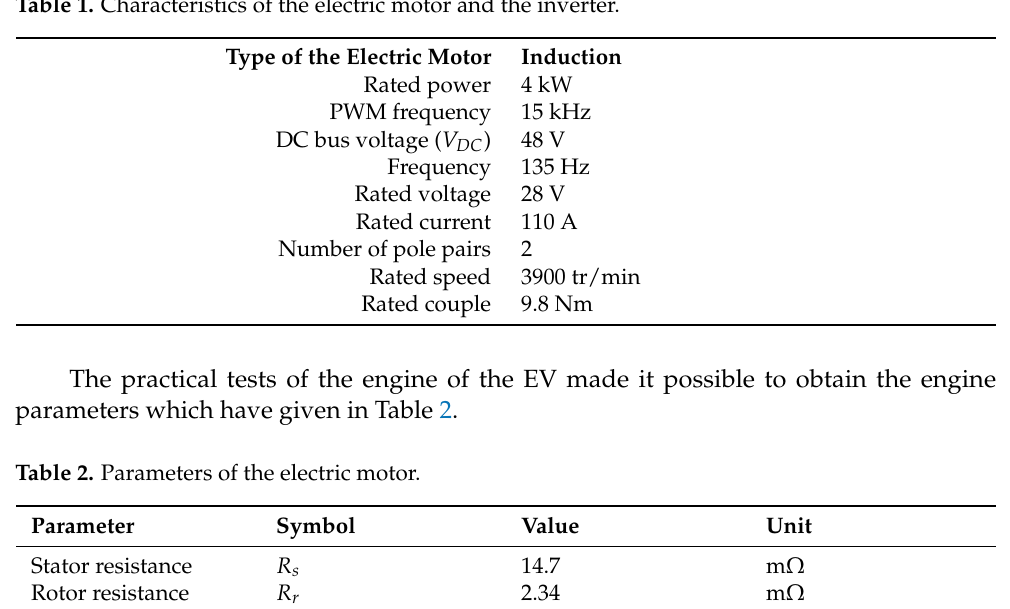
Table 1. Characteristics of the electric motor and the inverter.